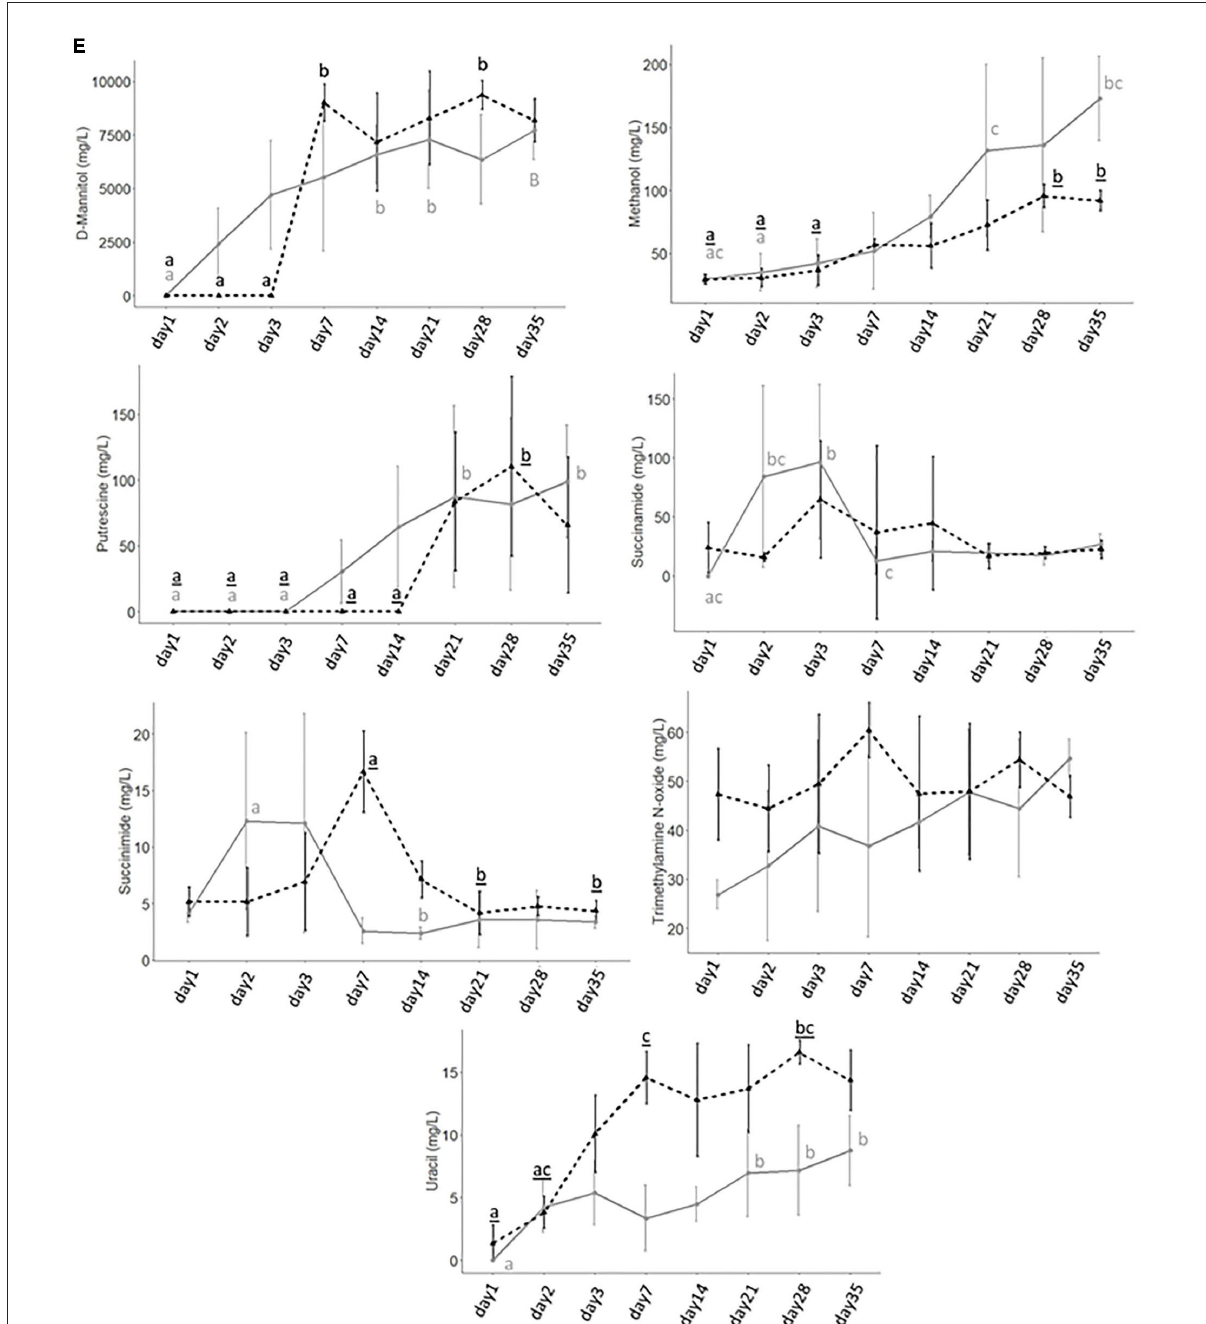
FIGURE3 Individual line plots of microbial metabolites identified by 1 H-NMR analysis, divided into (A) Organic acids, (B) Amino acids, (C) Sugars, (D) Other compounds, and (E) Other compounds. The plots compare the concentration (mg/L) changes between all experimental time points, after 1, 2, 3, 7, 14, 21, 28, and 35 days of fermentation. Different colors and line shapes indicate different producers: — SK1; - - - SK2. Plots represent the mean metabolite concentration ( n = 5 tanks for each producer), and the error bars correspond to the standard deviation. Different superscript letters indicate statistical significance among different time points, within the same producer ( p < 0.05) and capital letters indicate a p -value < 0.001. Gray-colored letters refer to SK1, and black underlined letters refer to SK2. No letter indicates no statistical significance after FDR